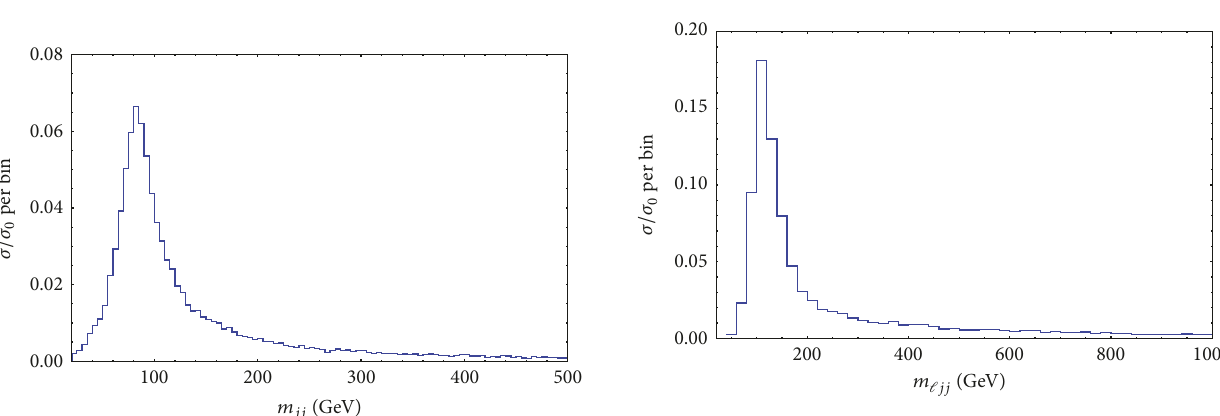
Figure 20: Rapidity distributions of the the leptons in the trilepton mode from VBF process.